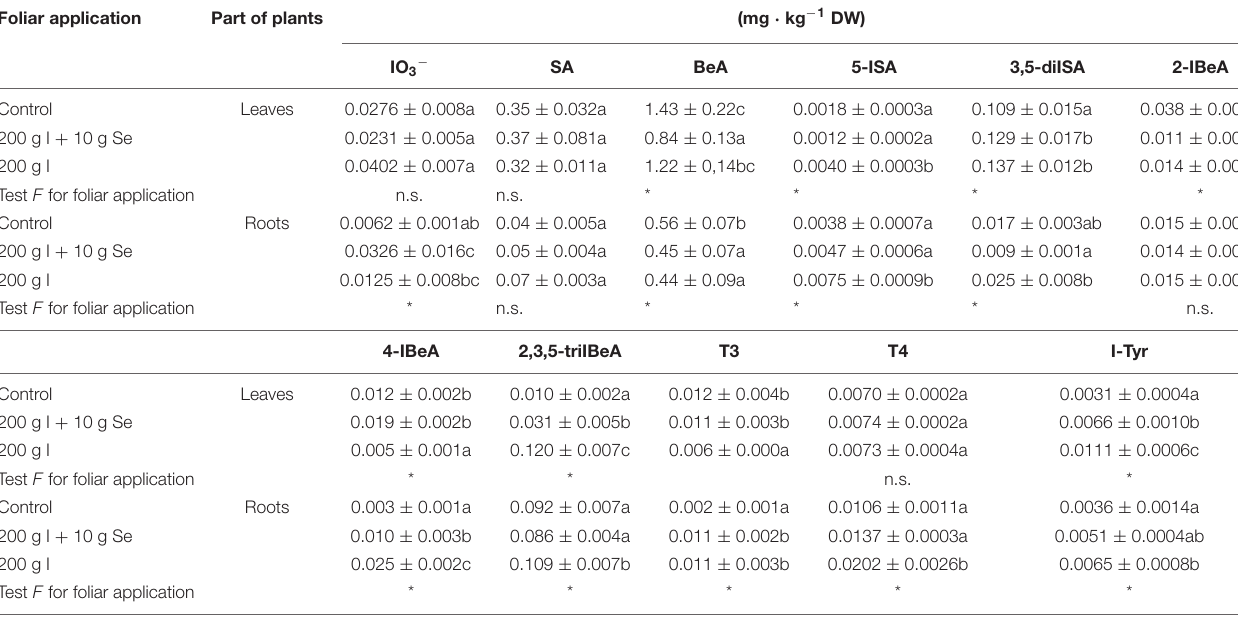
TABLE 6 | Content of iodates (IO 3 − ), salicylic acid (SA), benzoic acid (BeA), iodosalicylates [5-iodosalicylic acid (5-ISA) and 3,5-diiodosalicylic acid (3,5-diISA)], iodobenzoates [2-iodobenzoic acid (2-IBeA), 4-iodobenzoic acid (4-IBeA), 2,3,5-triiodobenzoic acid (2,3,5-triIBeA)], iodotyrosine (I-Tyr), and plant-derived thyroid hormone analogs (PDTHAs), i.e., triiodothyronine (T3) and thyroxine (T4) in carrot storage roots–results only from 1 year of study. Foliar application